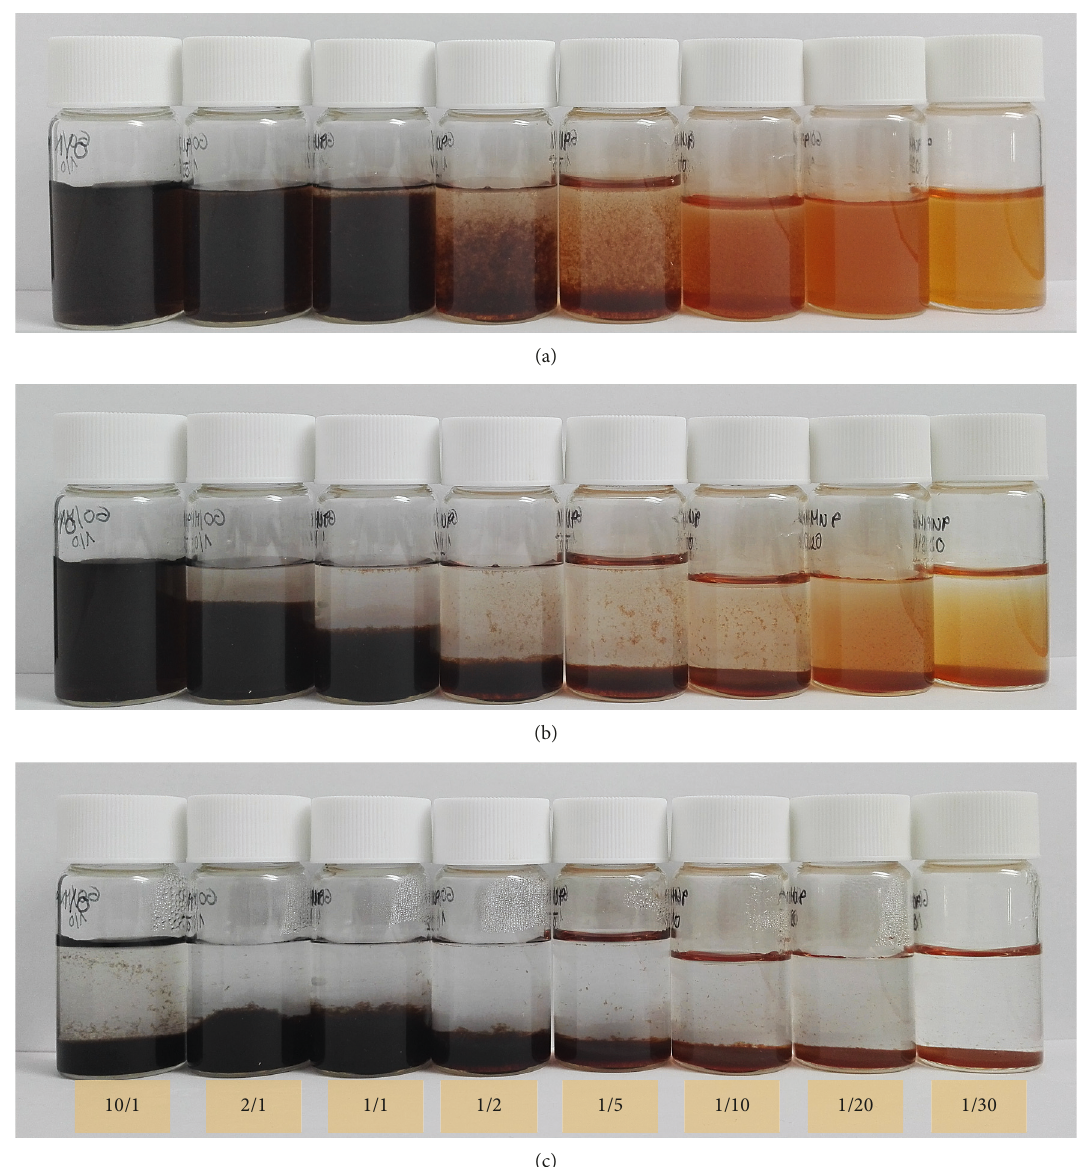
Figure 7: Photographs of settling nanocomposite dispersions immediately after homogenization (a), after one hour (b), and after one day (c). Numerical ratios indicated below (c) refer to different GO/MNP mass